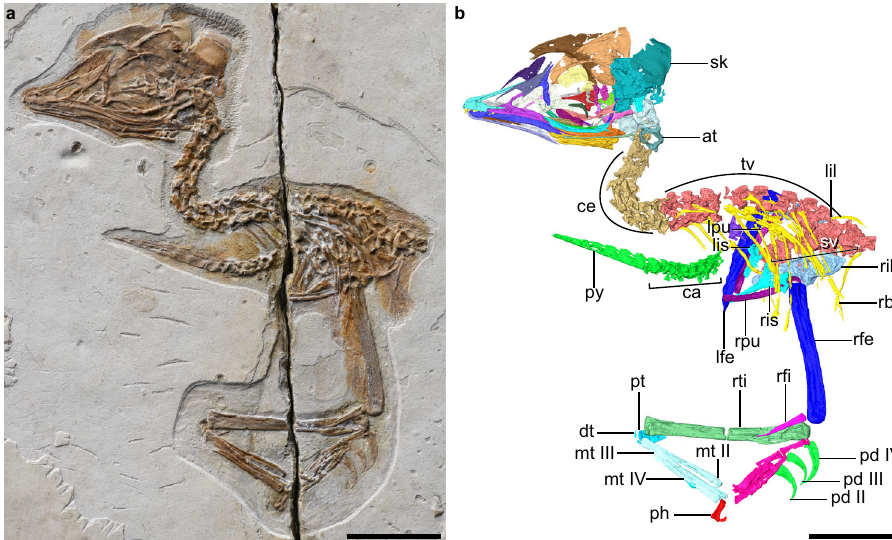
Fig. 1 Early Cretaceous enantiornithine IVPP V12707. a Photograph. b digital reconstruction. at atlas, ca caudal vertebrae, ce cervical vertebrae, dt distal tarsals, lfe left femur, lil left ilium, lis left ischium, lpu left pubis, mt II – IV metatarsals II to IV, pd II – IV pedal digits II to IV, ph proximal phalanx of hallux, pt proximal tarsals, py pygostyle, rb rib, rfe right femur, r fi right fi bula, ril right ilium, ris right ischium, rpu right pubis, rti right tibia, sk skull, sv sacral vertebra, tv thoracic vertebrae. Scale bars, 10